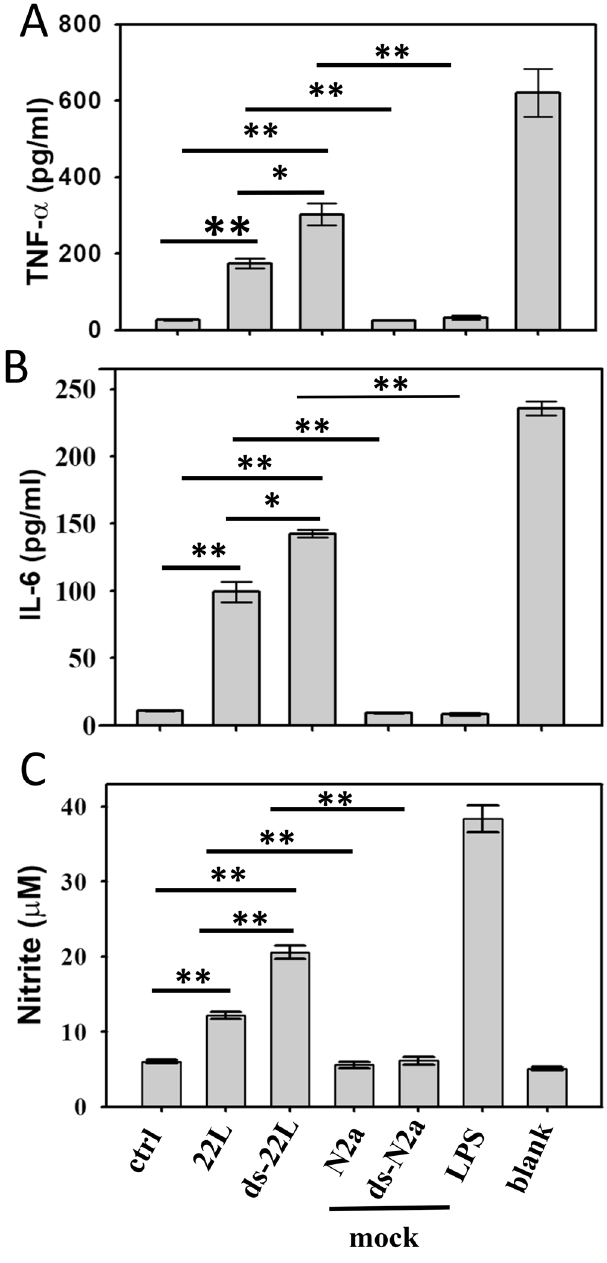
Figure 5. Analysis of proinflammatory responses in BV2 cells treated with cell-derived PrP Sc . Levels of TNF α ( A ) IL6 ( B ) and NO ( C ) measured upon incubation of BV2 cells with purified, ScN2a-derived 22L or ds-22L PrP Sc for 18 hours. As negative controls, cells were treated with mock-purified N2a or ds-N2a, or cultured in the absence of treatment (ctrl). As a positive control, cells were treated with LPS (100 ng/ml). The final concentrations of ScN2a-derived 22L or ds-22L PrP Sc in the cell culture media were equivalent to the amounts of PrP Sc in 0.15% 22L scrapie brain homogenate. All experiments were performed three times, and the data are presented as the mean ± SD. Statistical significance (P) were calculated by Student’s t-test and indicated as * and ** for P < 0.05 and P < 0.005,